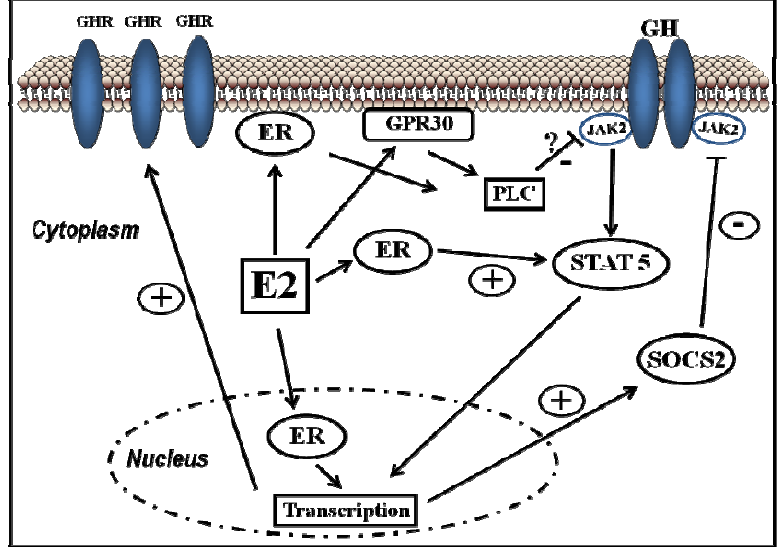
Figure 3. Signalling pathways activated by E2 and its crosstalk with growth